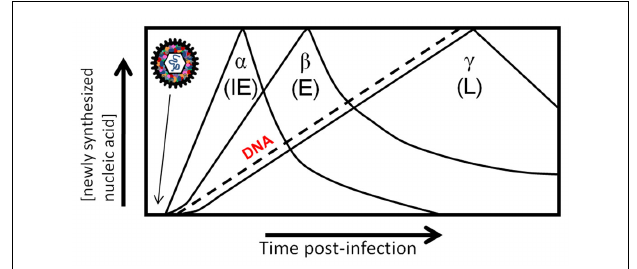
FIGURE 1 | Schematic of herpesvirus virion. The herpesvirus virion is composed of an icosahedral capsid containing the double-stranded DNA genome, a lipid envelope decorated with virally encoded glycoproteins, and a layer filled with proteins termed the tegument which resides between the capsid and the envelope.The likely sites for packaged coding and non-coding RNAs are the tegument and the capsid.There is evidence for RNA–protein interactions in the tegument, but it is unclear whether all packaged RNAs interact with tegument proteins. Although it is possible, we are unaware of evidence for protein–RNA interactions in the nucleus, or RNA–RNA interactions in either the nucleus or tegument.